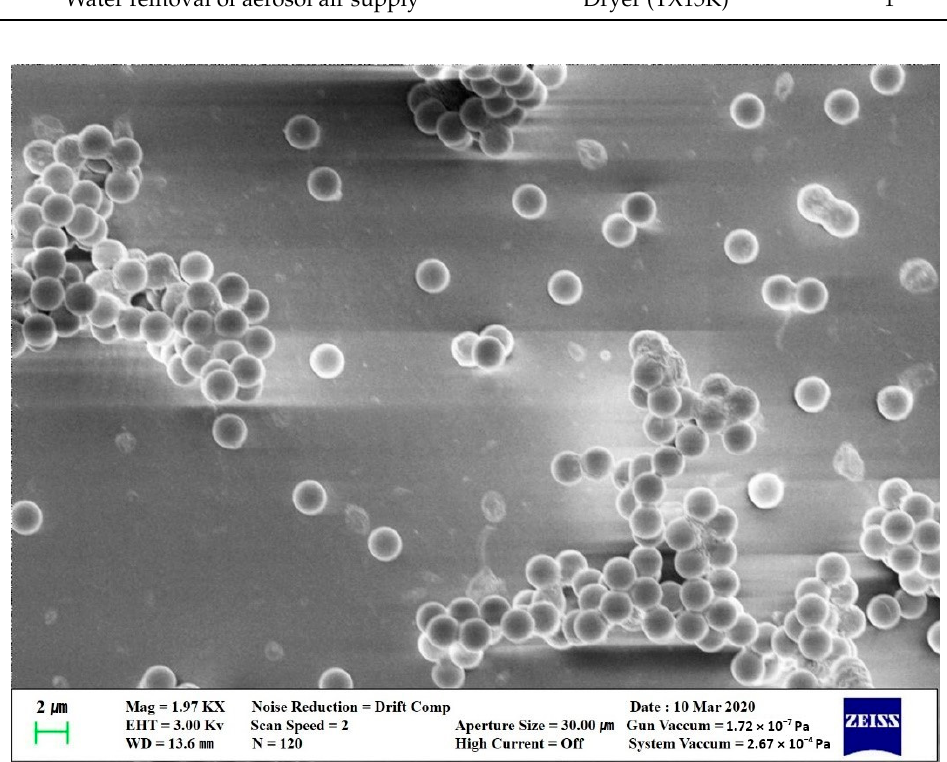
Figure 2. Expanded picture of standard solution through a scanning electron microscope (SEM).